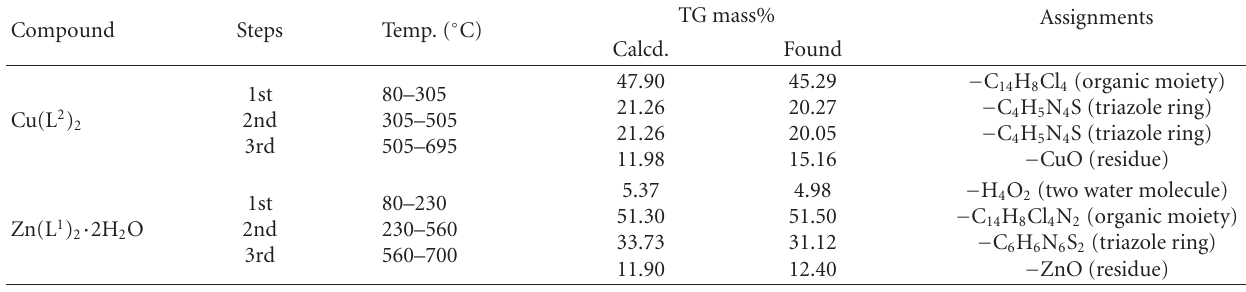
Table 4: Thermoanalytical results (TG) of the metal complexes.